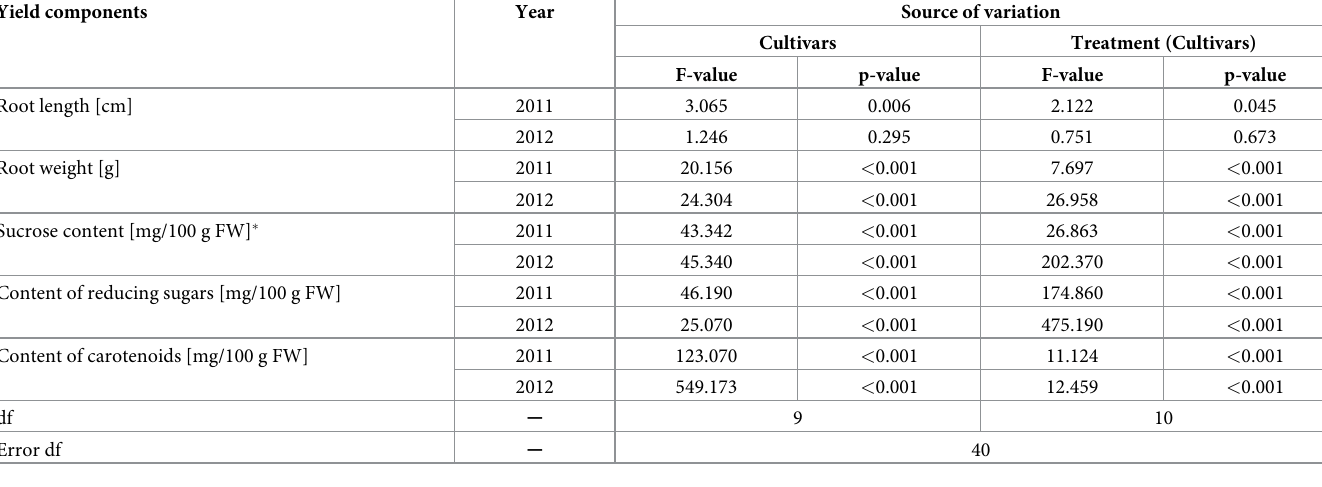
Table 6. Two-way nested ANOVA for indicators (yield components) of the degree of tolerance to the hawthorn-carrot aphid, Dysaphis crataegi . Yield